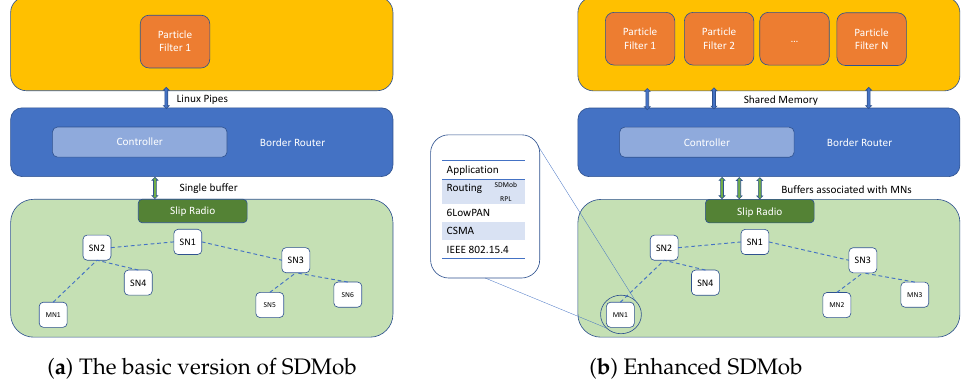
Figure 2. A schematic view of the basic SDMob architecture in ( a ) supporting a single mobile node compared with enhanced SDMob ( b ) with multiple mobile nodes and